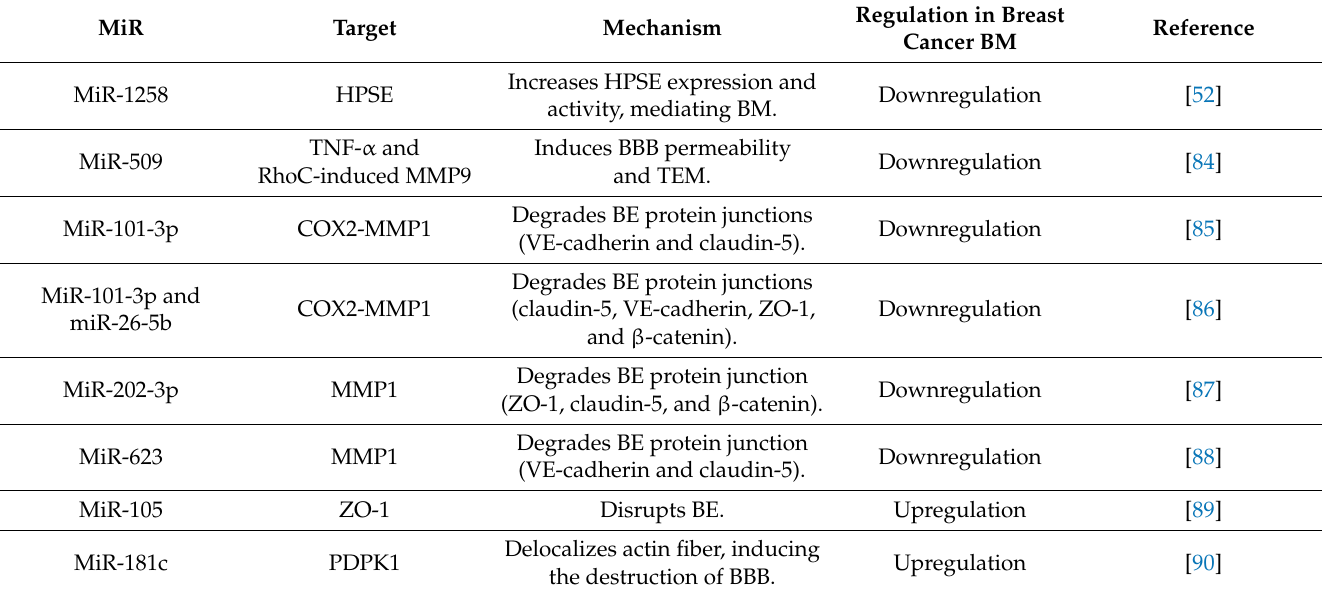
Table 2. MicroRNAs that mediate extravasation in breast cancer brain